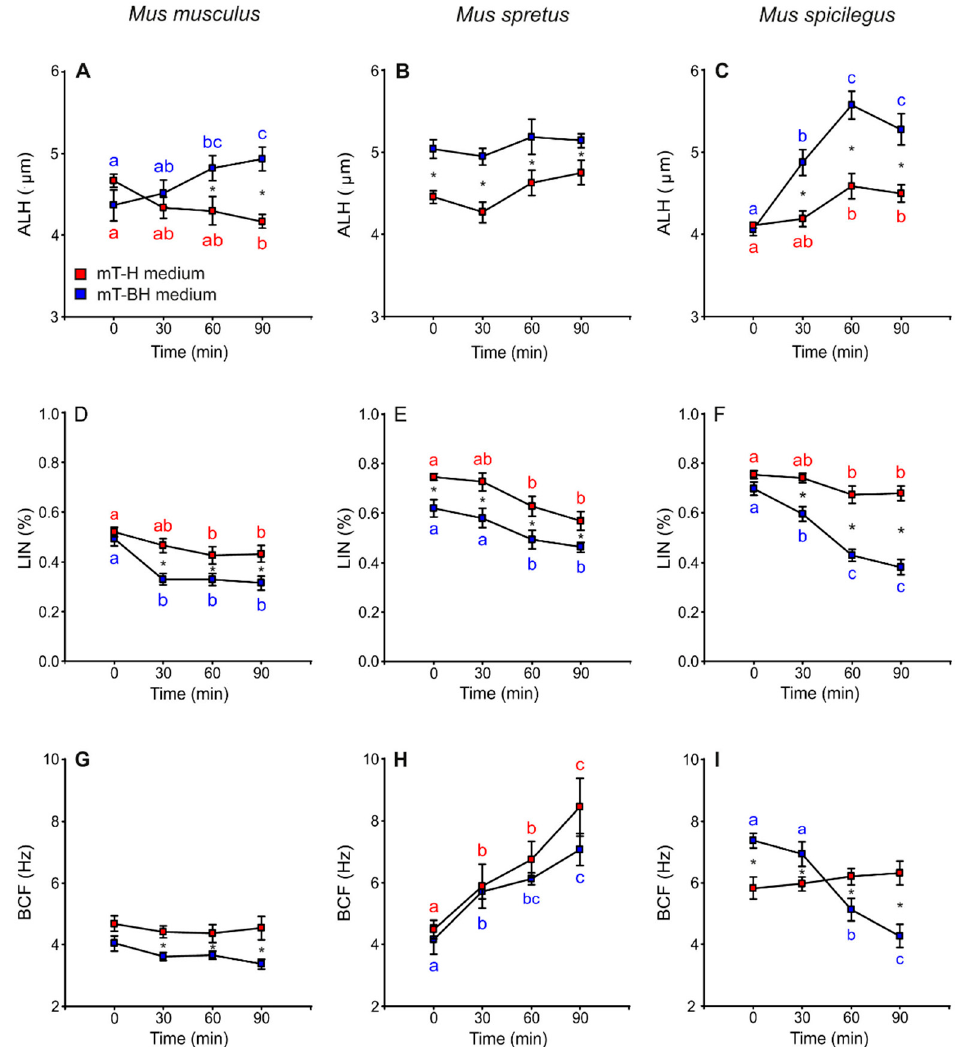
Figure 4. Variation in sperm swimming parameters (ALH, LIN and BCF) from three mouse species ( M. musculus , M. spretus , M. spicilegus ) incubated under non-capacitating conditions (mT-H medium) and capacitating conditions (mT-BH medium). Data are means ± SE ( n = 7 in M. musculus , n = 8 in M. spretus , and n = 6 in M. spicilegus ). Red squares: non-capacitating conditions, mT-H medium under air. Blue squares: capacitating conditions, mT-BH medium under 5% CO 2 /air. ( A – C ) Lateral head displacement (ALH) (µm). ( D – F ) Linearity (LIN) (VCL/VSL) (%). ( G – H ) Beat cross frequency (BCF) (Hz). ( A , D , G ) M. musculus . ( B , E , H ) M. spretus. ( C , F , I ) M. spicilegus . Asterisks indicate signifi-